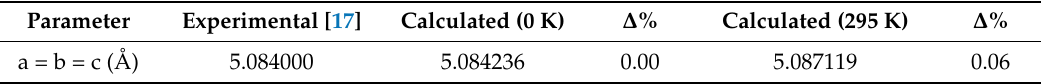
Table 4. Comparison of calculated and experimental lattice